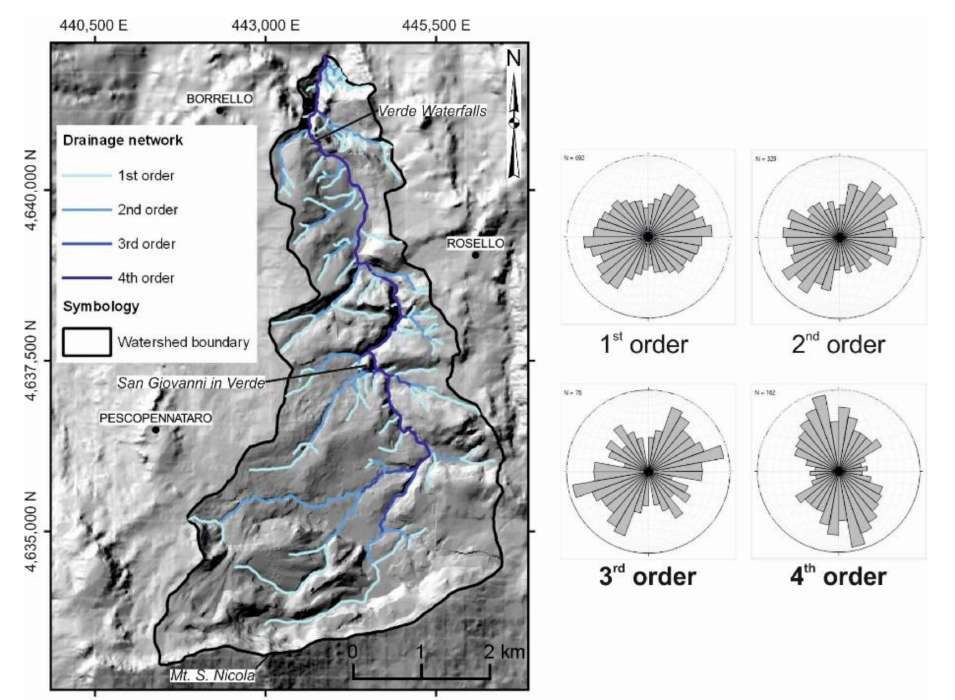
Figure 7. Drainage network divided into hierarchical orders (according to Strahler [65]) and drainage lines azimuth distribution for each